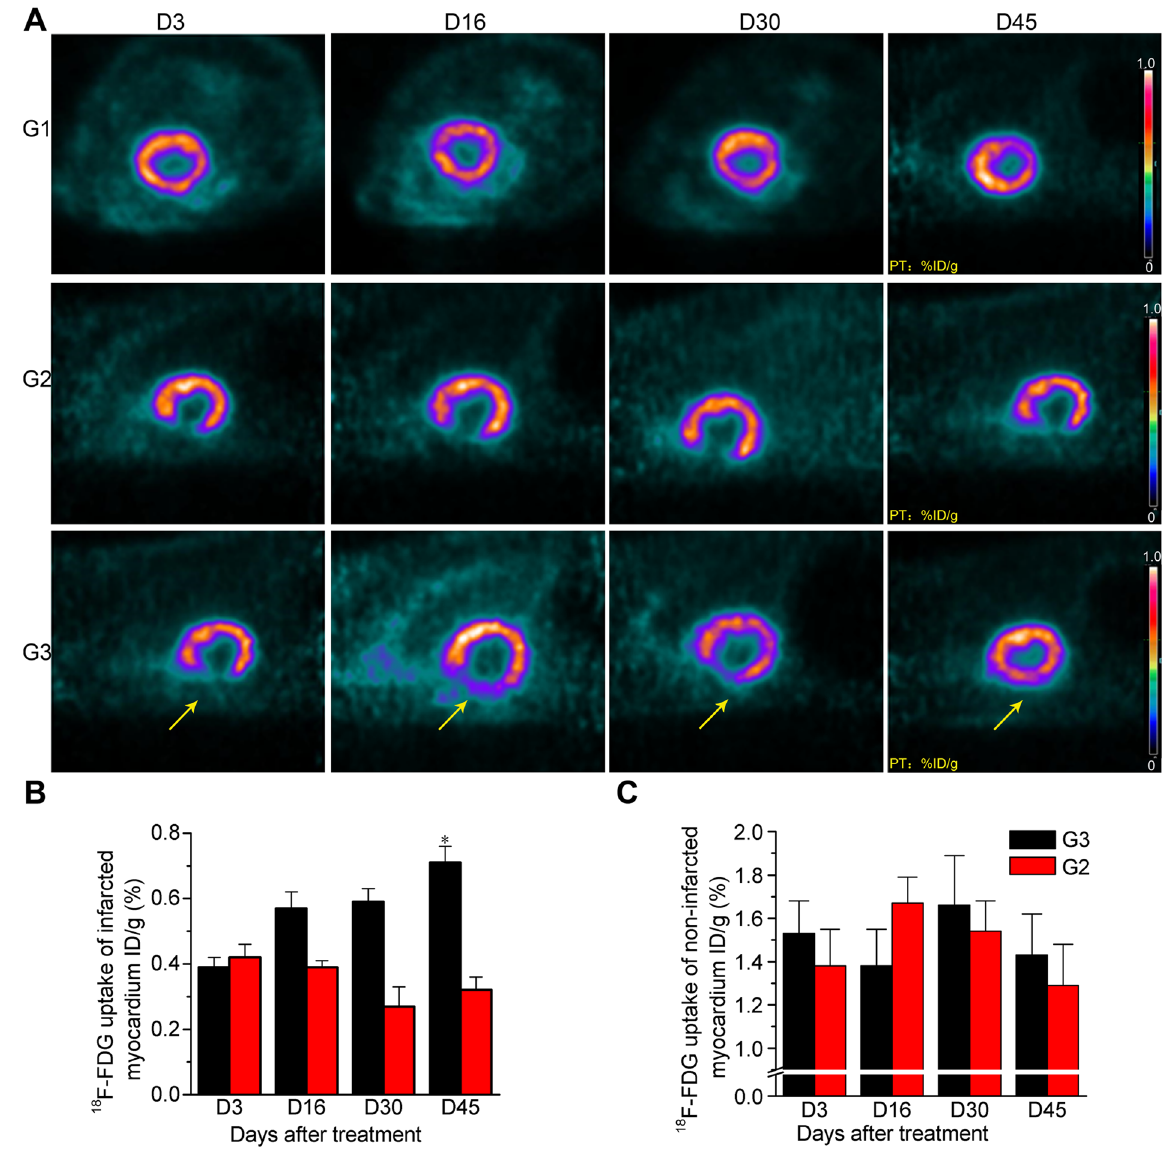
Figure 3. Myocardial activity measured using 18 F-FDG microPET imaging ( A ), and 18 F-FDG uptake in infarcted ( B ) and non-infarcted ( C ) myocardium of the MI model (G2) and transfected-BMSC-treated MI model (G3) groups during the therapy phase. Yellow arrows indicate transplanted BMSCs * P <